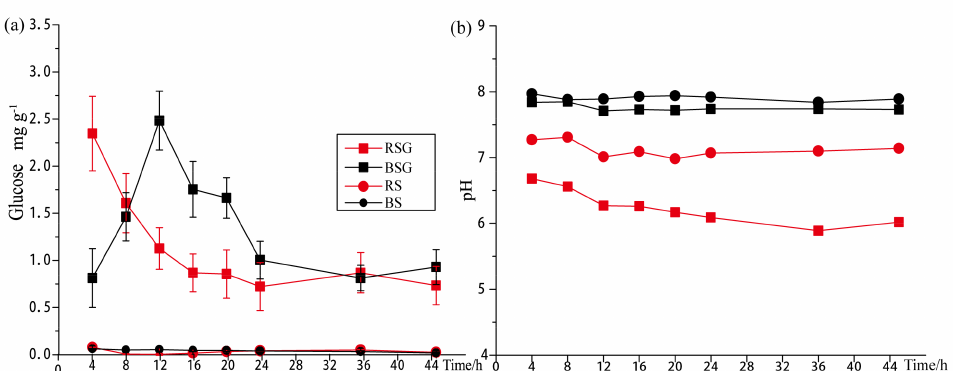
Figure 2. ( a ) Changes of glucose (mg · g − 1 ), and ( b ) pH during the experiment in the four wetland